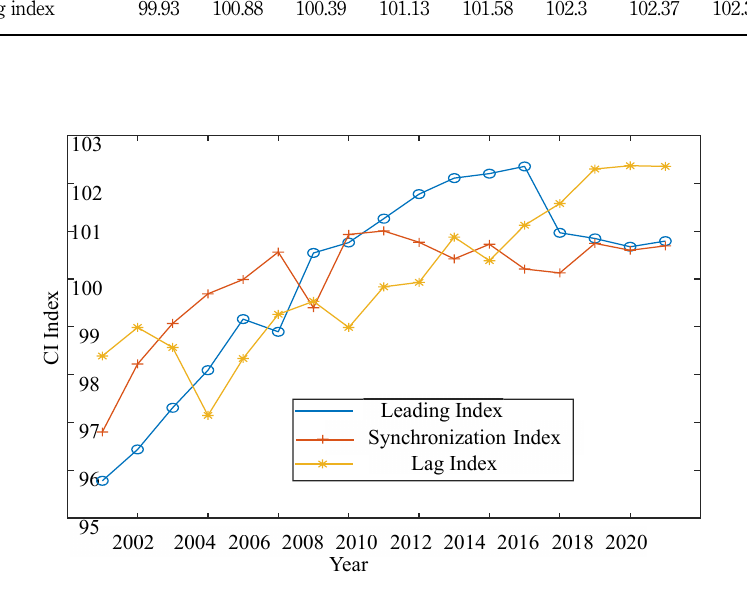
Table 1. Composite index of